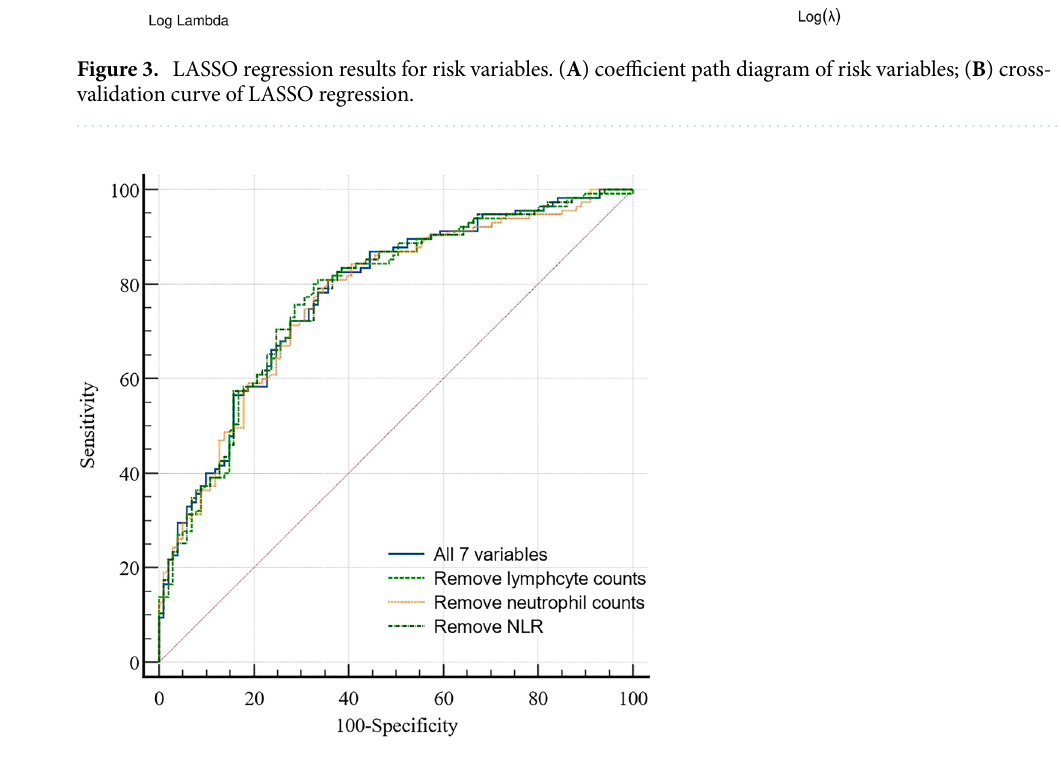
Figure 4. Comparison of ROC curves of nomogram models incorporating different variables to predict STR <